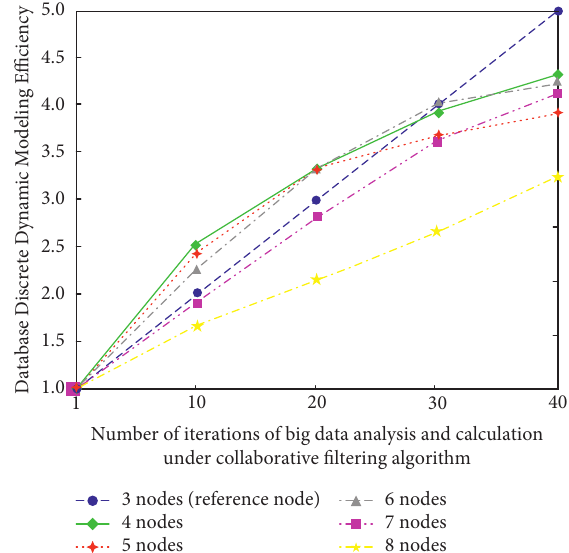
Figure 3: Simulation results of changes in the process of discrete dynamic modeling under different optimization times of collab- orative filtering